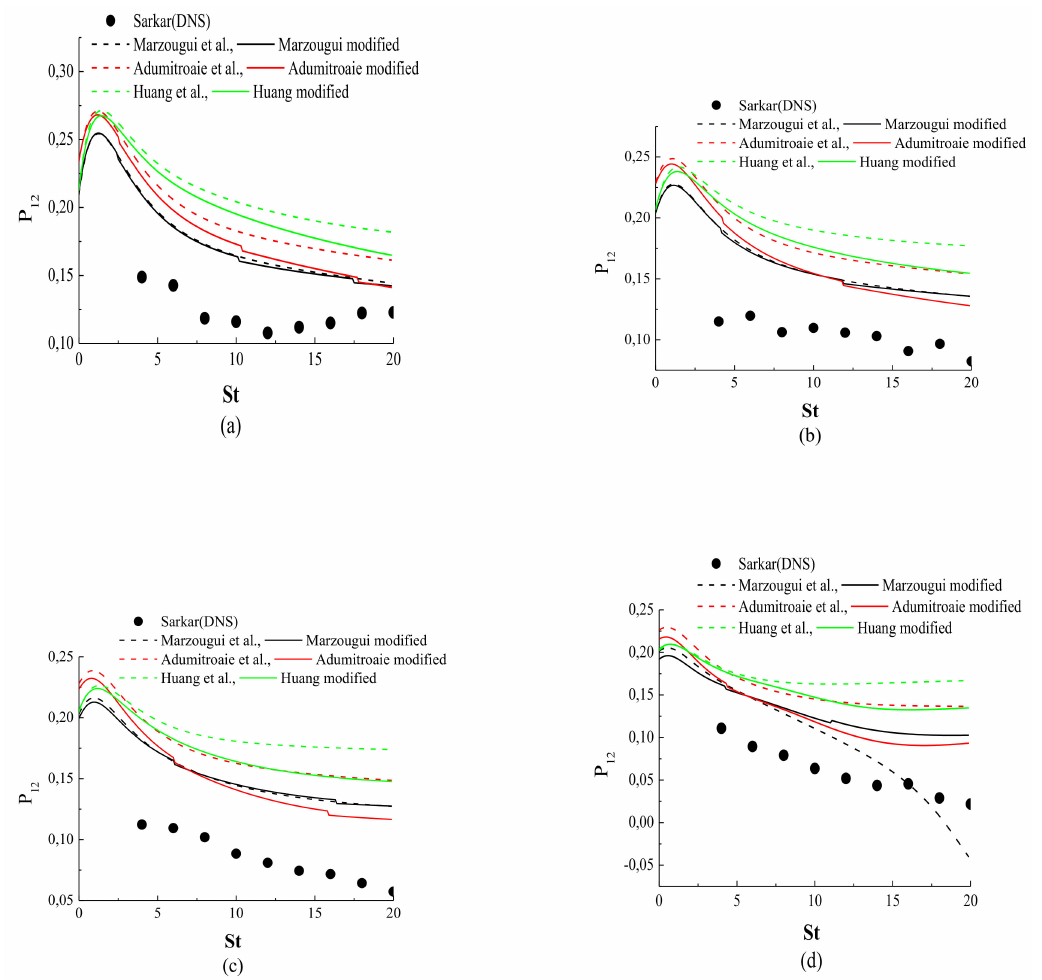
Figure 8. Time evolution of the pressure-strain component in the following cases: ( a ) A1, ( b ) A2; ( c ) A3; ( d ) A4.